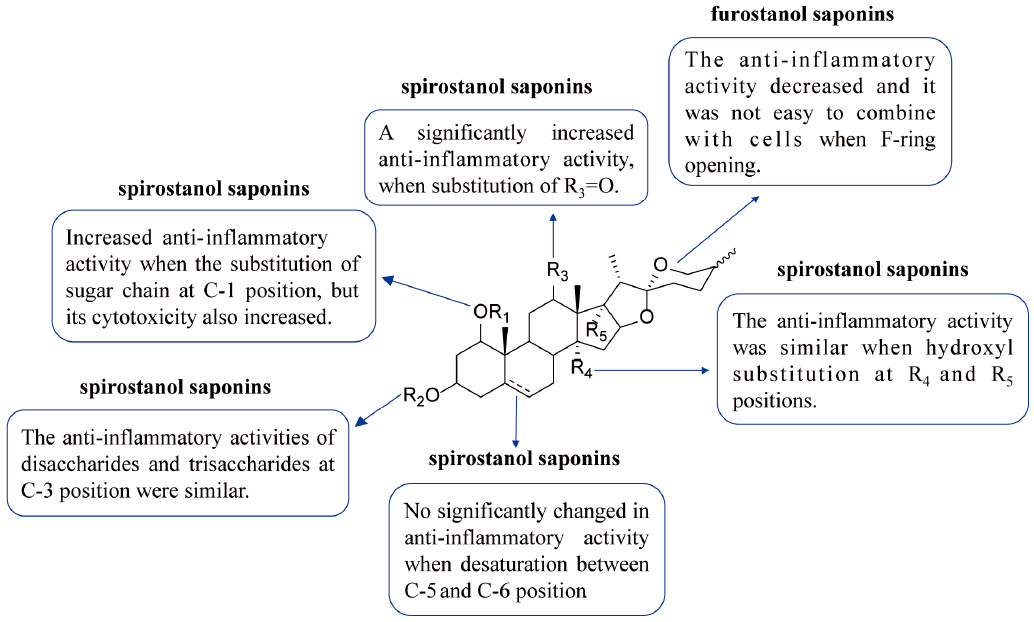
Figure 7. Structure–activity relationship involved in anti ‐ inflammatory activity of spirostanol saponins and furostanol saponins in EDG.